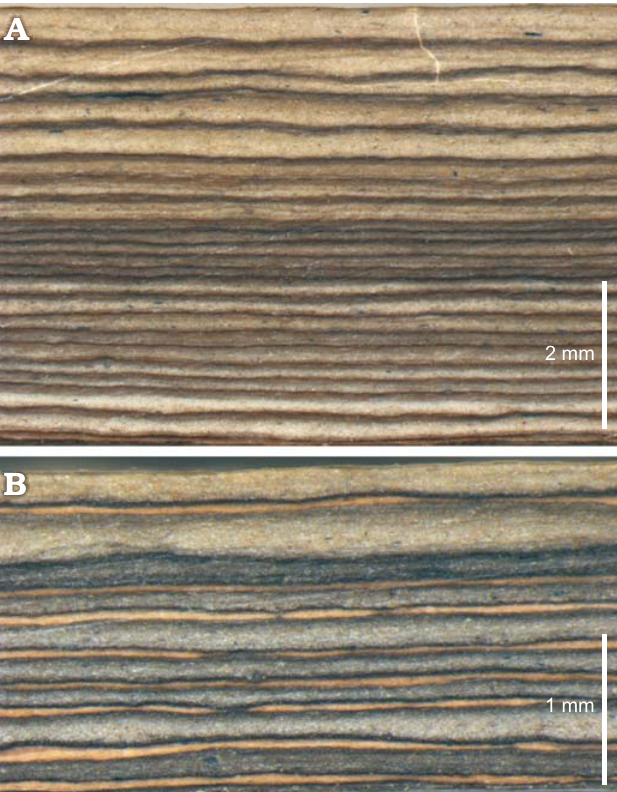
Fig. 4. Micrographs of cross-sections of two pieces of oil shale from the Coal Creek member of the Kishenehn Formation, Eocene, Montana, USA. A . Shale (USNM 560099), 6 mm thick, from the Pisces site showing rhyth- mite couplets of varying thickness. B . Shale (USNM 560100), 2 mm thick, from the Dakin site showing rhythmites comprised of three distinct layers: A lower thick gray layer of siliciclastic particles, an adjacent thin tan layer of calcite and an uppermost black carbonaceous